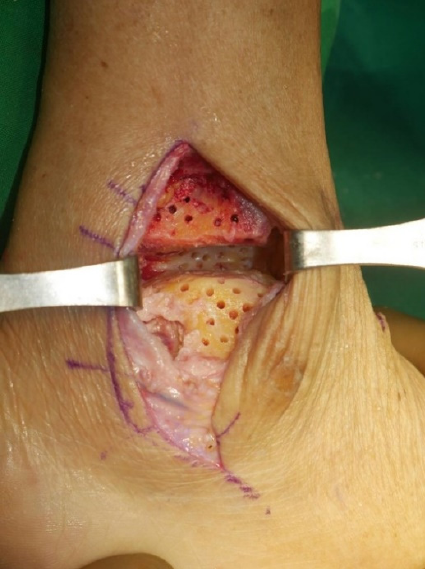
Figure 4. The cartilage and subchondral bone of the tibiotalar joint was removed using curettes, osteotomes, and burrs through the lateral ankle joint.